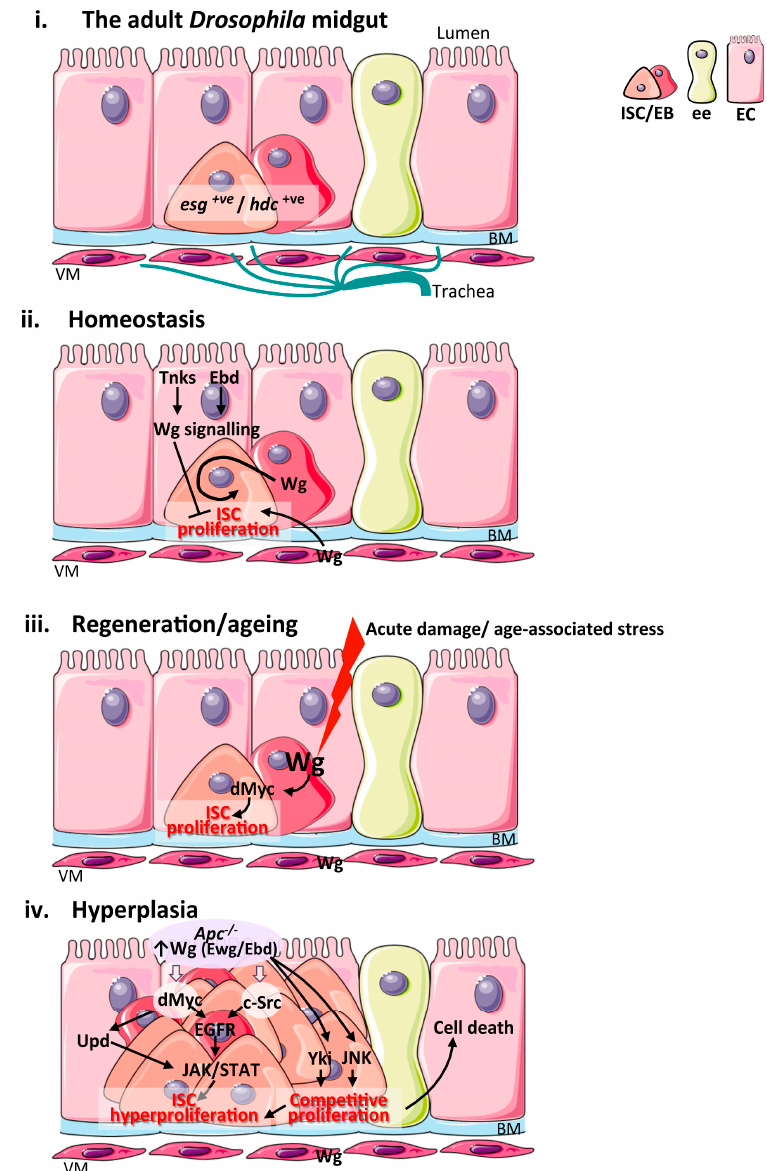
Figure 2. Wnt signalling in the adult Drosophila midgut during homeostasis, regeneration, ageing and hyperplasia. ( i ) Schematic of the cellular composition and architecture of the adult Drosophila midgut epithelium and its microenvironment; ( ii ) Main sources of the Wnt stem cell niche and pathway activation during intestinal homeostasis. The VM and EBs produce Wg ligand to active signalling within ISC and drive their proliferation. Wg signalling activation in ECs by Tnks and Ebd inhibit ISC proliferation non-autonomously; ( iii ) Sources of the Wg stem cell niche and pathway activation during intestinal regeneration following damage and upon ageing. Up-regulation of Wg from EBs activates Wg signalling and its downstream target dMyc to drive ISC proliferation. The VM niche expresses Wg but is dispensable for ISC proliferation in this context; ( iv ) Wnt pathway activation during intestinal hyperplasia and functional pathways downstream of Apc . JNK and Yki activation in Apc − / − cells drive ISC proliferation and cell competition leading to apoptosis of neighbouring wild type cells. ISC: intestinal stem cell; EB: enteroblast; EC: enterocyte; ee: enteroendocrine cell; BM: basement membrane; VM: visceral muscle; esg : escargot ; hdc : headase ; Wg: Wingless; Tnks: Tankyrase; Ebd: Earthbound; Ewg: Erect wing; Yki: Yorkie; JNK: c-Jun N-terminal kinase; Upds: Unpaired cytokines; EGFR: Epithelial growth factor receptor; JAK: Janus